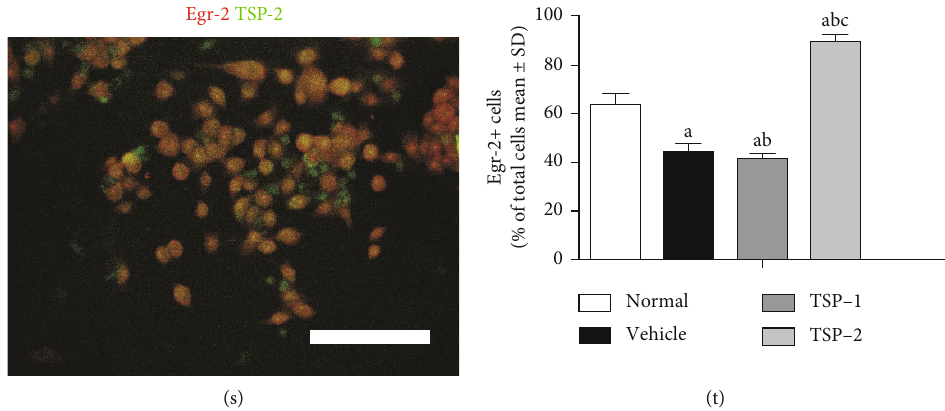
Figure 1: TSP-1 and TSP-2 overexpression a ff ects macrophage polarization in vitro . MH-S murine alveolar macrophage cells were either untreated (normal and nontreatment) or treated with LPS (1 μ g/ml) for 24h following either empty vector (vehicle group), TSP-1 (TSP-1 group), or TSP-2 (TSP-2 group) overexpression. Cells were harvested and used for immunostaining of M1 (CD38 and Fpr-2) and M2 (Agr-1 and Egr-2) macrophage markers. (a – d) CD38 staining; (f – i) Fpr-2 staining; (k – n) Agr-1 staining; (p – s) Egr-2 staining in normal, vehicle, and TSP-1- and TSP-2-overexpressing cells, respectively. Red staining represents expression of speci fi c markers, Hoechst 33342 blue staining represents the nuclei, and green staining represents GFP-labeled TSP-1 and TSP-2 overexpression. The yellow color depicts overlay image of speci fi c markers and TSP expression in the same cell. Positively stained cells for speci fi c markers in each group were counted and are shown in a bar graph in (e, j, o, and t). The percentage of labeled cells/total cell numbers is shown as mean ± SD . P value of < 0.05 represents signi fi cant di ff erence. a P < 0 : 05 compared with normal control; b P < 0 : 05 compared with vehicle group; c P < 0 : 05 compared with TSP-1 transfected group ( n = 5 per e ff ects of TSP-1 and TSP-2 overexpression on apoptosis in